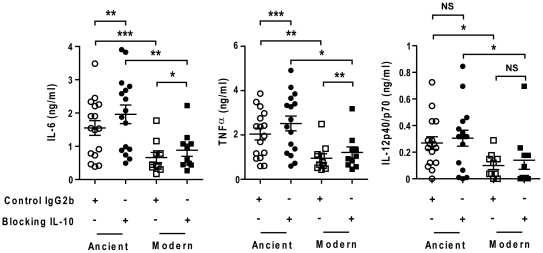
The delayed inflammatory response of modern lineage is not due to IL-10.Scatter plot representation of Type 1 macrophage cytokine response from a single donor 24 h post-infection towards ancient (circles) versus modern (squares) groups of strains in the presence (filled) or absence (open) of anti-IL-10 blocking antibodies. IL-10 blockage resulted in a significant increase in the production of IL-6 and TNFα independent of lineage. The delayed inflammatory response to strains from modern lineages is not due to IL-10 regulatory activity (Paired t-test for intra-group comparison and Mann-Whitney U test for inter-group comparison, * P<0.05, ** P<0.01 and *** P<0.001).